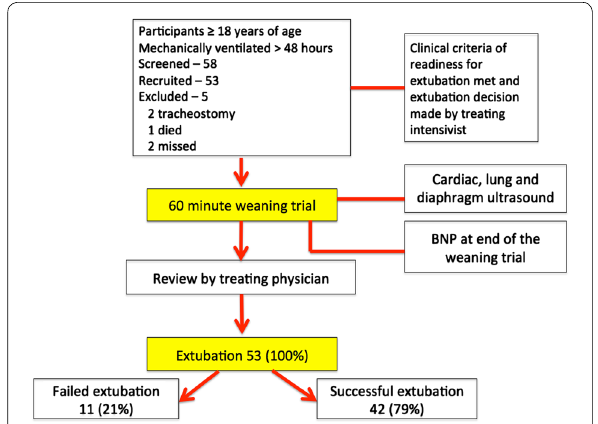
Fig. 1 The participants’ flow